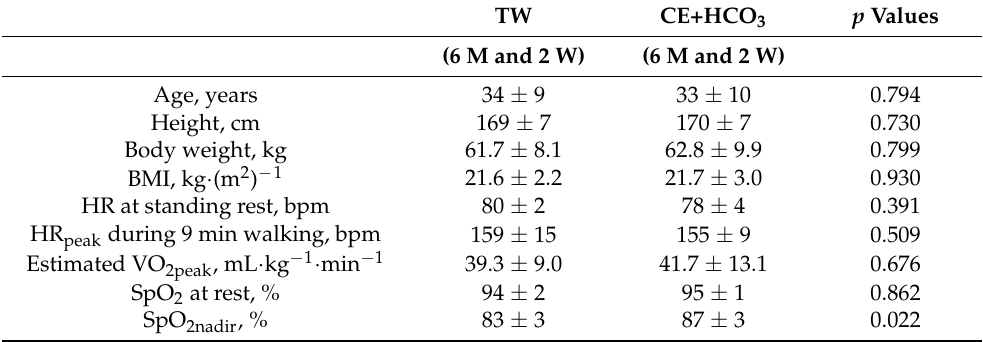
Table 1. Physical characteristics, heart rate, estimated VO 2peak , and SpO 2nadir in the two groups.